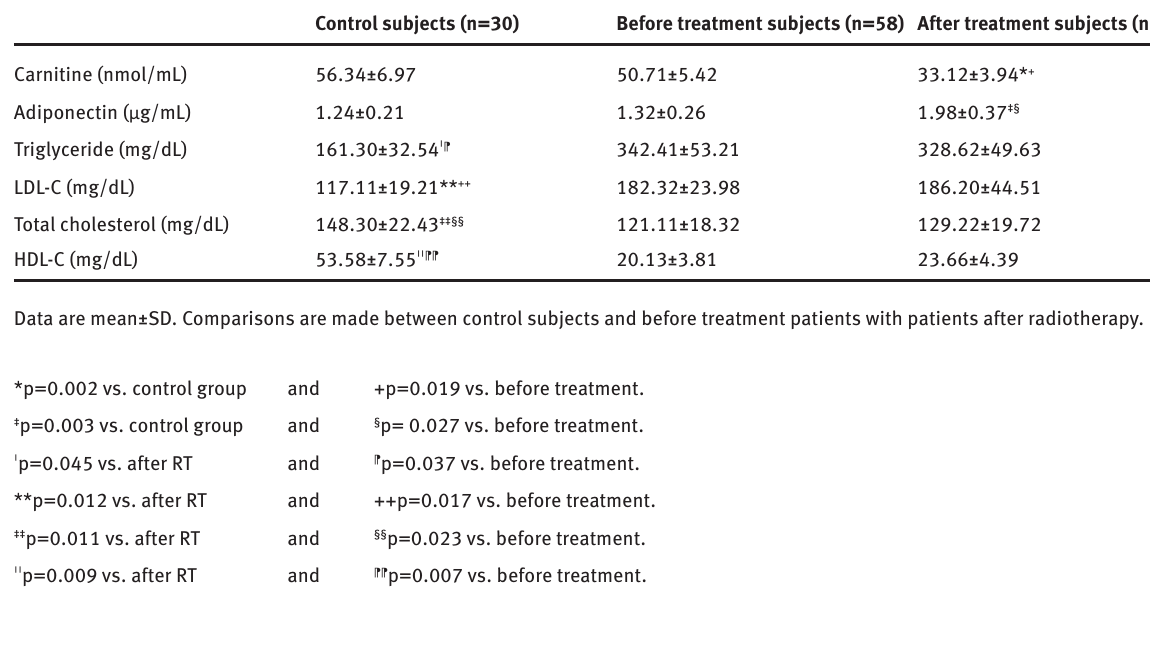
Control subjects